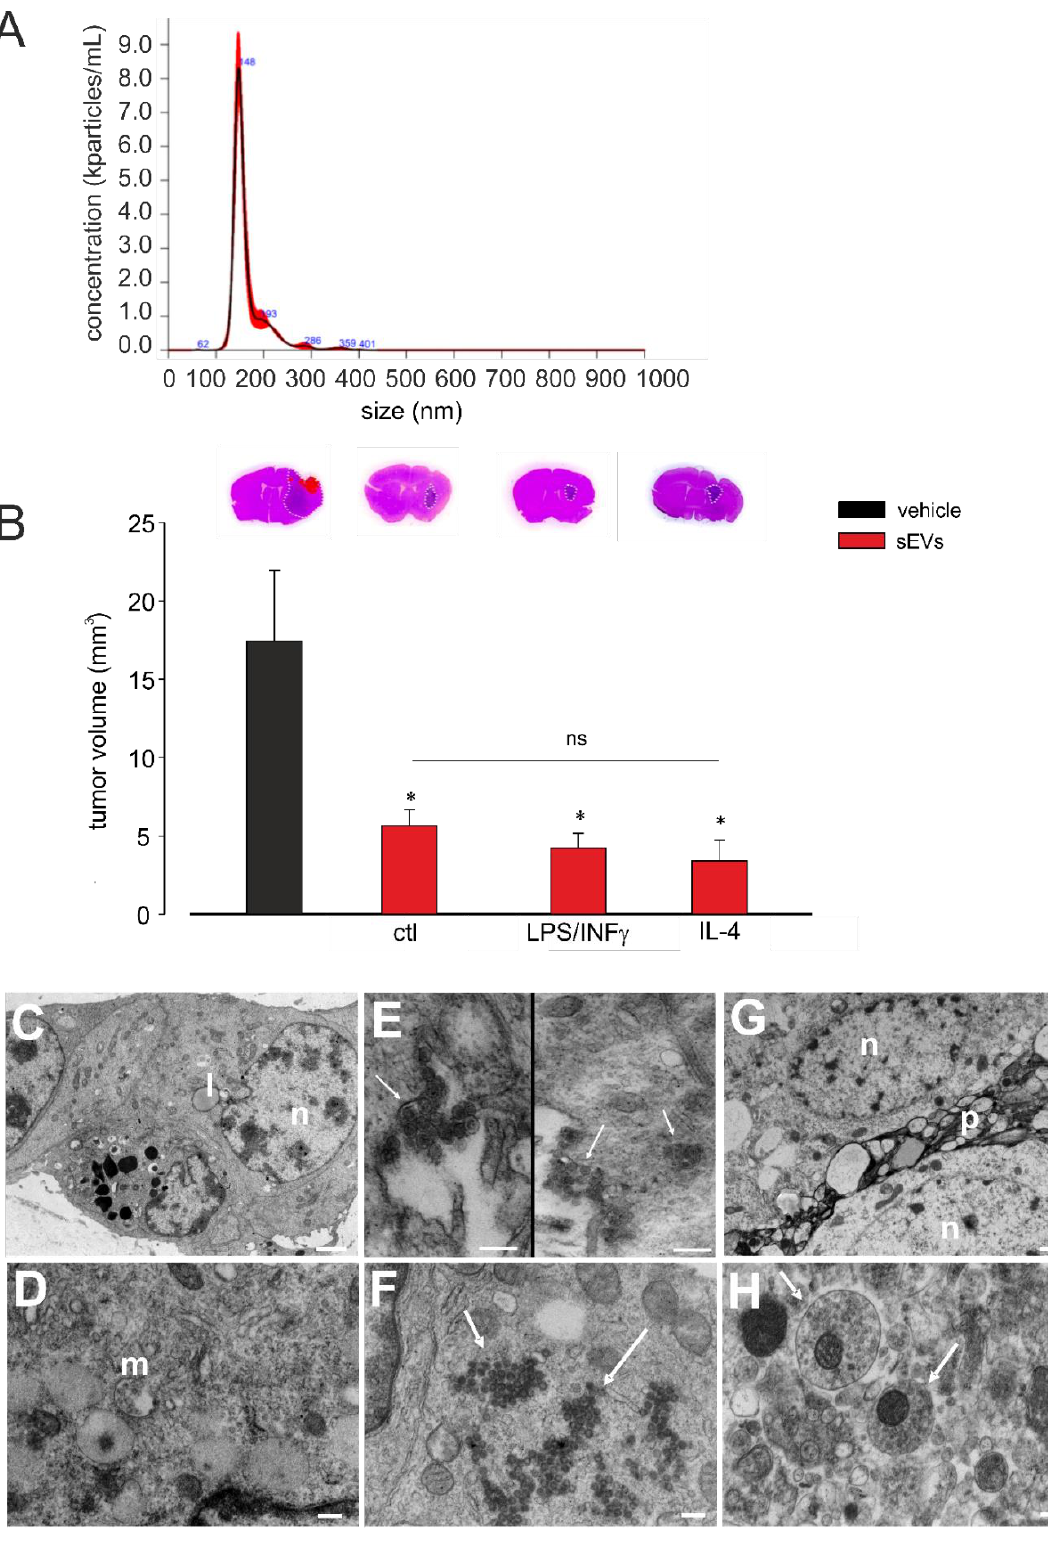
Figure 1. Size and concentration analysis of microglia-derived small extracellular vesicles (sEVs), their effects in glioma- bearing mice and their morphological analysis. ( A ) Representative concentration/size graph from the nanoparticle tracking analysis (NTA) of BV2-derived sEVs. The mean concentration (±standard error, SE; in particles/mL) and mean size (±SE; in nm) of sEVs, obtained from five independent experiments, are reported in the main text. ( B ) Tumor size in the brain of GL261-bearing mice treated with an sEVs-free fraction isolated from the cell medium of BV2 cells (vehicle) and sEVs isolated from the cell medium of untreated (ctl), lipopolysaccharide/interferon-γ (LPS/IFNγ)-treated, or interleukin